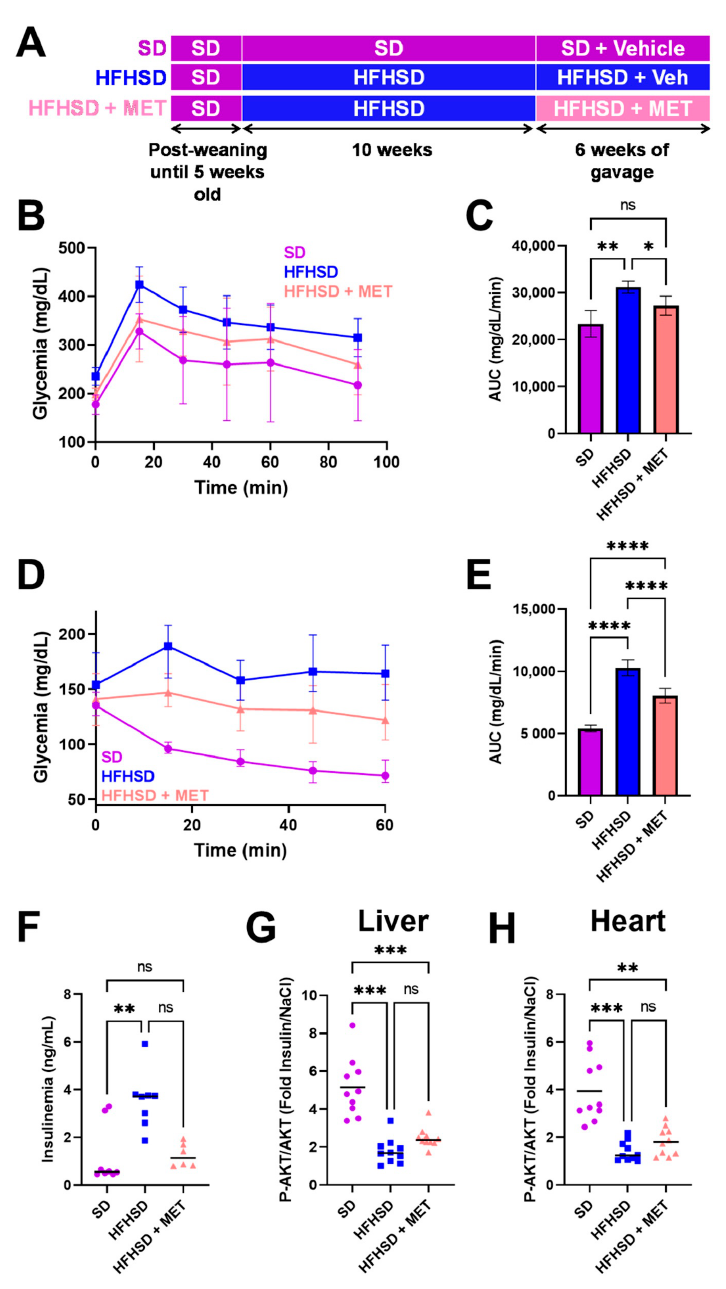
Figure 1. Evaluation of metformin effects on the metabolic status of the HFHSD mice. ( A ) Time- line of the experimental protocol. Daily oral gavage consisted on either metformin (200 mg/kg, HFHSD + MET) or the vehicle (0.5% methylcellulose). Measurements of glycemia following a glu- cose ( B ) or insulin ( D ) tolerance test, and respective quantification of the area under curve (AUC) in ( C , E ) (n = 5 mice/group for GTT and 14–15 mice/group for ITT). Mean ± SD, Brown–Forsythe, and Welch ANOVA test. ( F ) Quantification of blood insulin level. ( G , H ) Analysis of insulin sensitivity in liver ( G ) and heart ( H ) by quantification of the cardiac phosphorylation of AKT (on Ser473), calculated as a fold increase of insulin-induced AKT phosphorylation over NaCl (n = 10 mice/group). Mean, Brown–Forsythe, and Welch ANOVA test. * p < 0.05, ** p < 0.005, *** p < 0.001, **** p < 0.0001. ns = non-significant. Symbols: circle: SD, square: HFHSD, triangle: HFHSD +